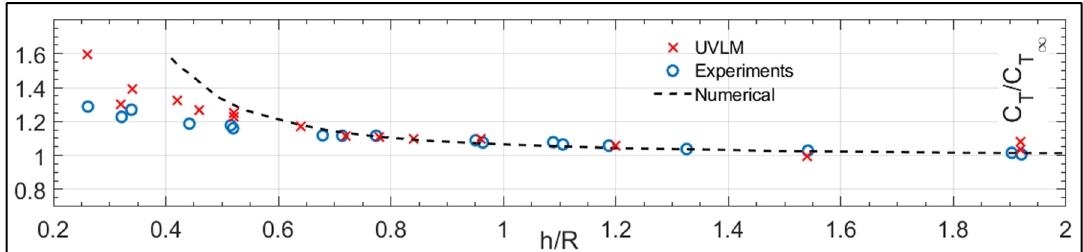
Figure 10. C T predictions in ground of UVLM compared to numerical and experimental data.